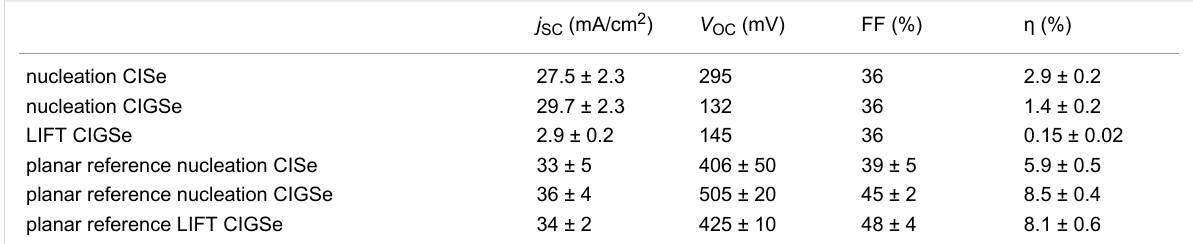
Table 1: Solar-cell parameters at 1 sun illumination compared for micro cells fabricated from the different local absorbers and the corresponding planar reference